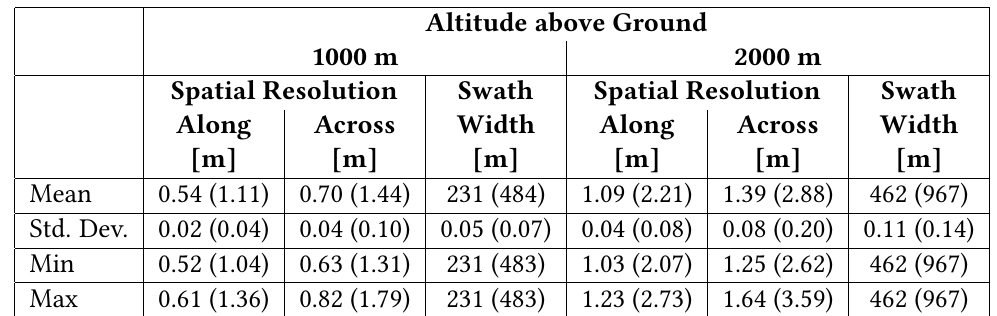
Table 2: Selection of geometric parameters for the HySpex SWIR-320m-e at two typical flight altitudes. Values in brackets are obtained with FOV expander lens attached.